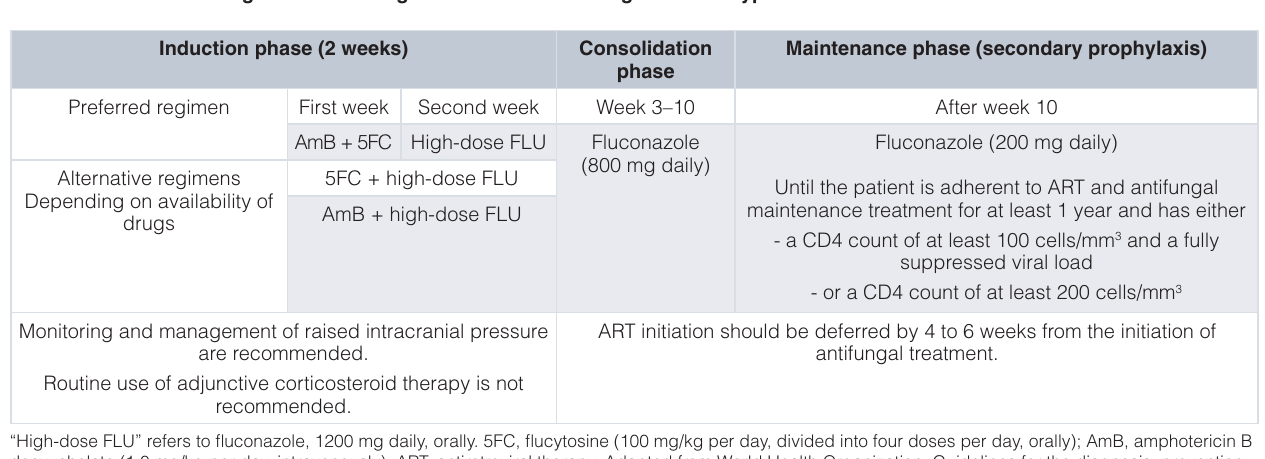
Table 1. World Health Organization 2018 guidelines for the management of cryptococcal disease in adults with